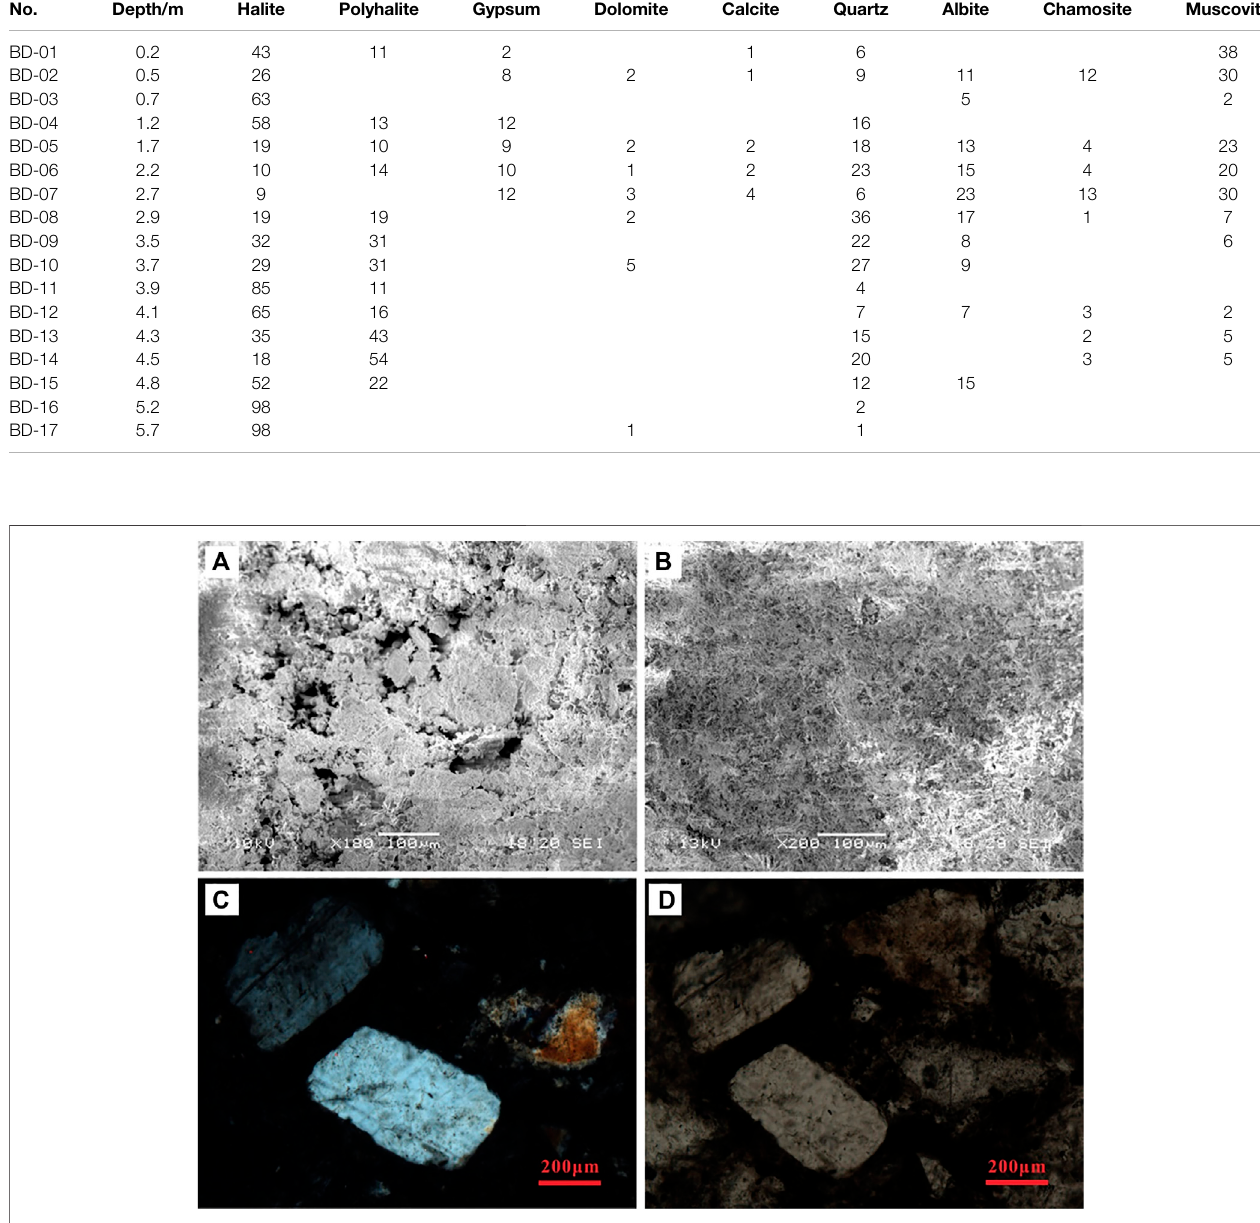
Frontiers in Earth Science |